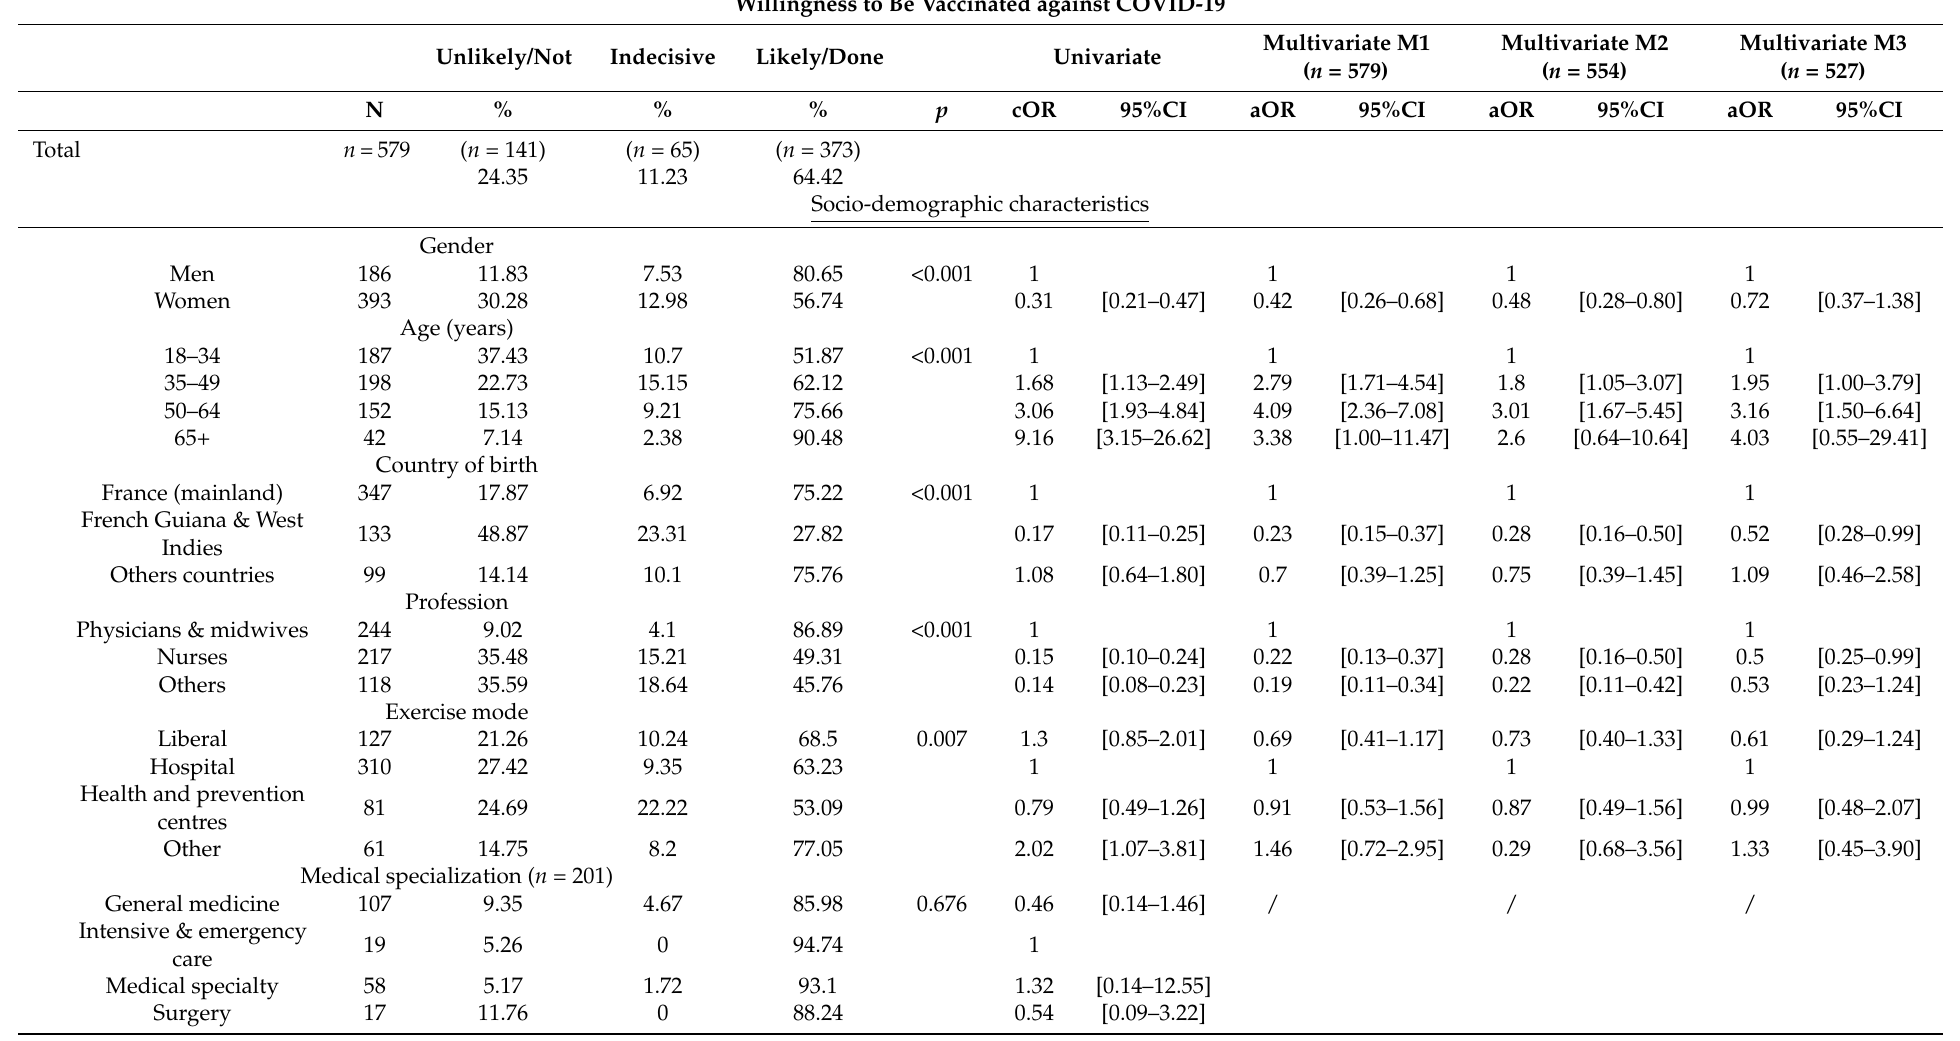
Table 4. Factors associated with willingness to be vaccinated against COVID-19 (Likely / Indecisive / Unlikely or Not). Ordinal multivariate logistic regression. Willingness to Be Vaccinated against COVID-19 Multivariate Unlikely/Not Indecisive Likely/Done Univariate